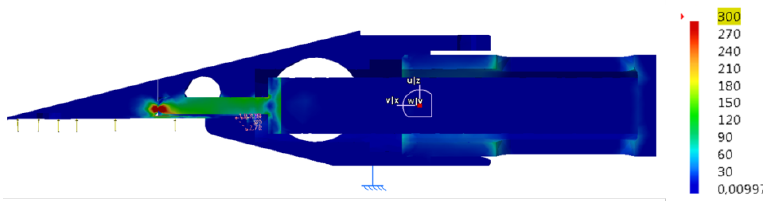
Figure 8. Exemplary result of a finite element calculation of the lip (von Mises stress); the highest loads are found at the contact point between the punch and the metal lip; no critical load cases were found.